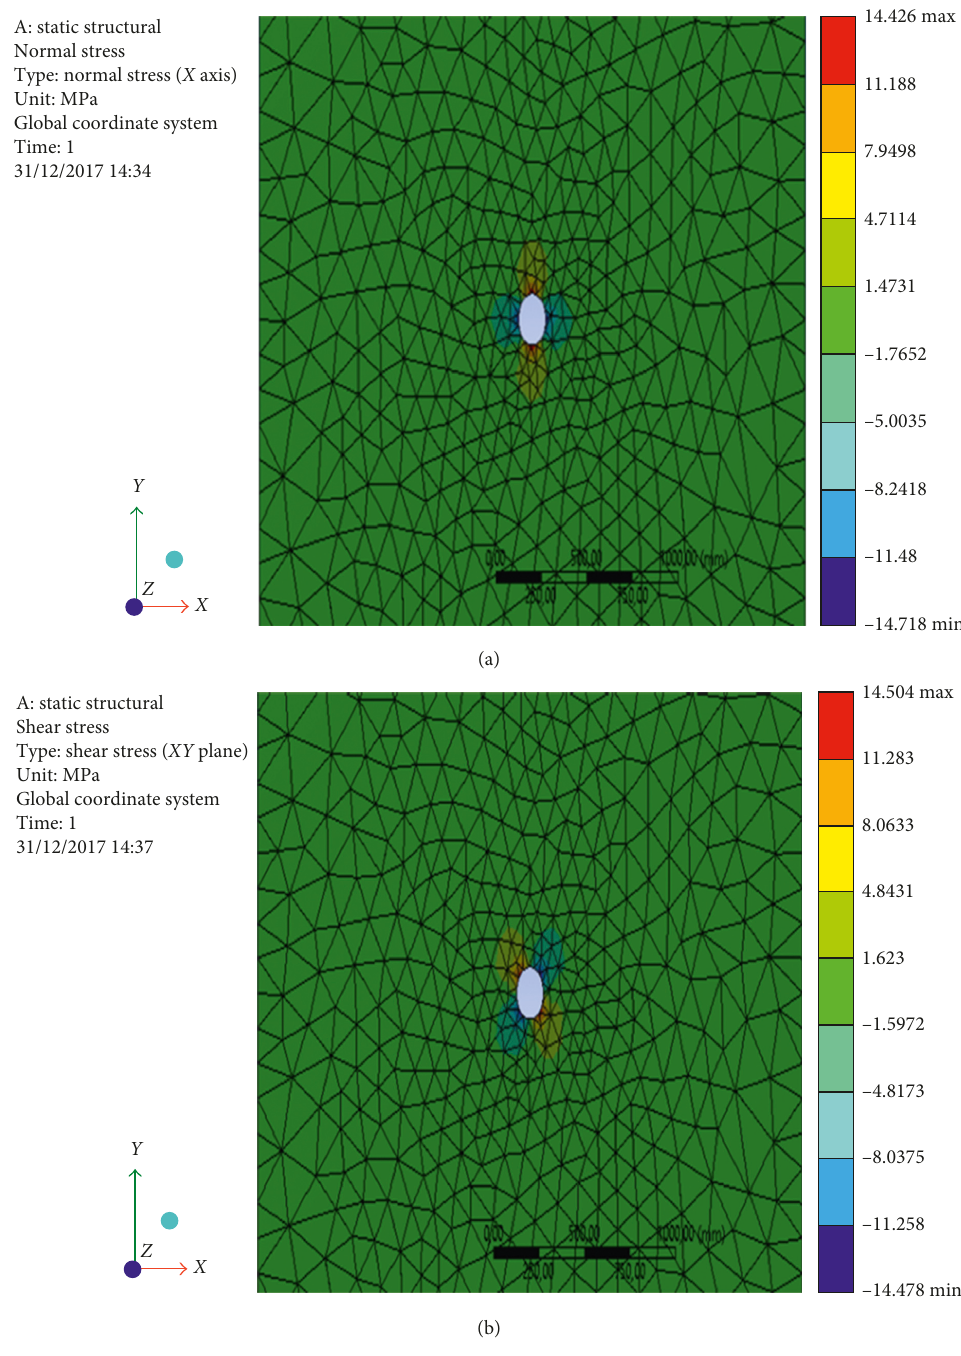
Figure 4: Redistribution of (a) normal stresses and (b) tangential